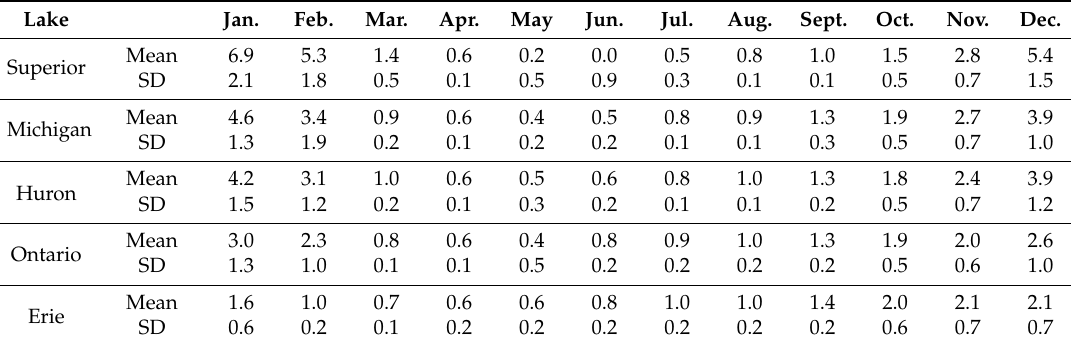
Table 6. Summary of monthly mean lake-wide evaporation rate (mm per day).